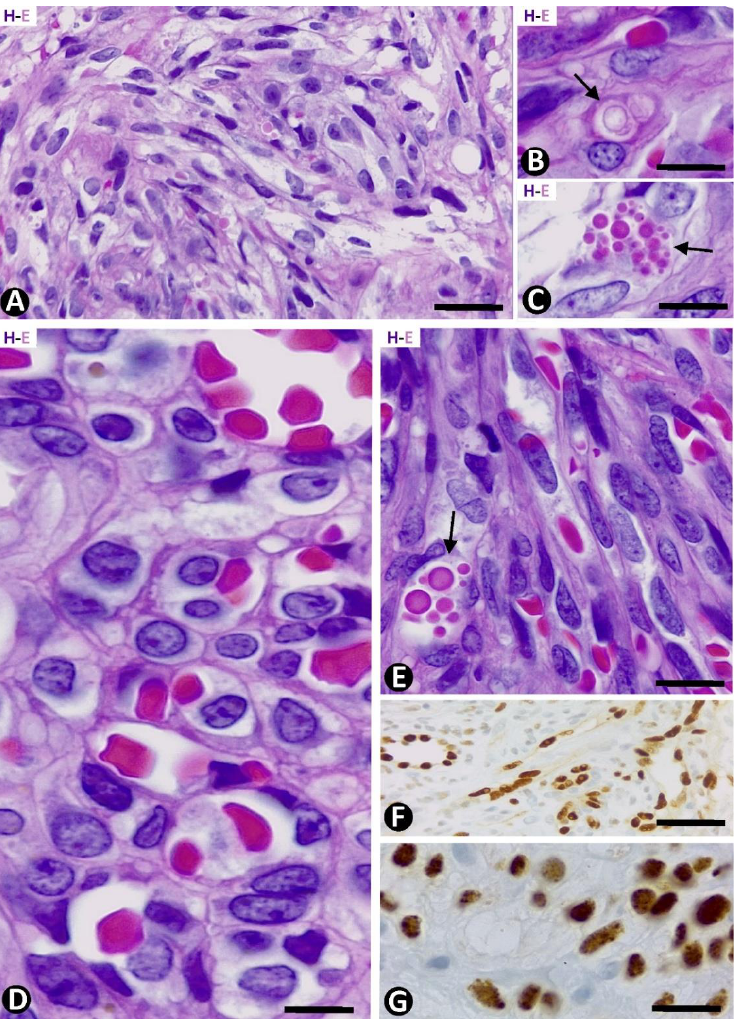
Figure 2. ( A – C ): KS in the plaque stage. Fusiform cells forming narrow cords with virtual or erythrocyte-occupied lumens are observed in ( A ). Note degraded red blood cells incorporated in the cytoplasm of an EC in ( B ) (arrow) and hyaline bodies in ( C ) (arrow). ( D , E ): KS in the nodular stage. High cellular fascicles of spindle cells ( E ) with intraluminal red blood cells. Note a honeycomb-like pattern in a cross-section in ( D ) and hyaline bodies in ( E ) (arrow). ( F ): Nuclear expression for ERG in KS ECs. ( G ): Human herpesvirus 8 (HHV-8) expression. ( A – E ) Hematoxylin and eosin. ( F , G ): Immunochemistry for ERG and HHV-8, respectively. Bar: ( A , F ): 20 µ m; ( B , C , E , G ): 15 µ m; ( D ): 10 µ